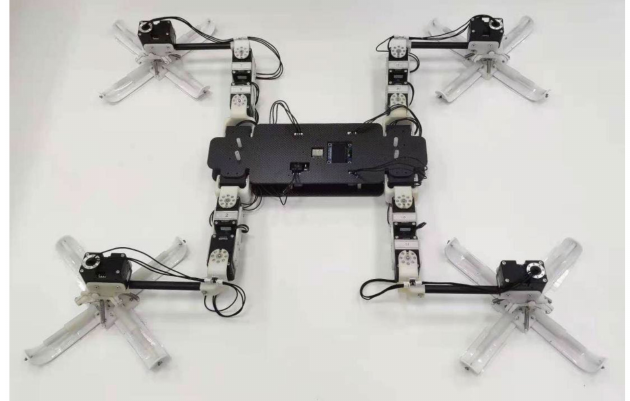
Figure 17. Image of the gecko-inspired robot.